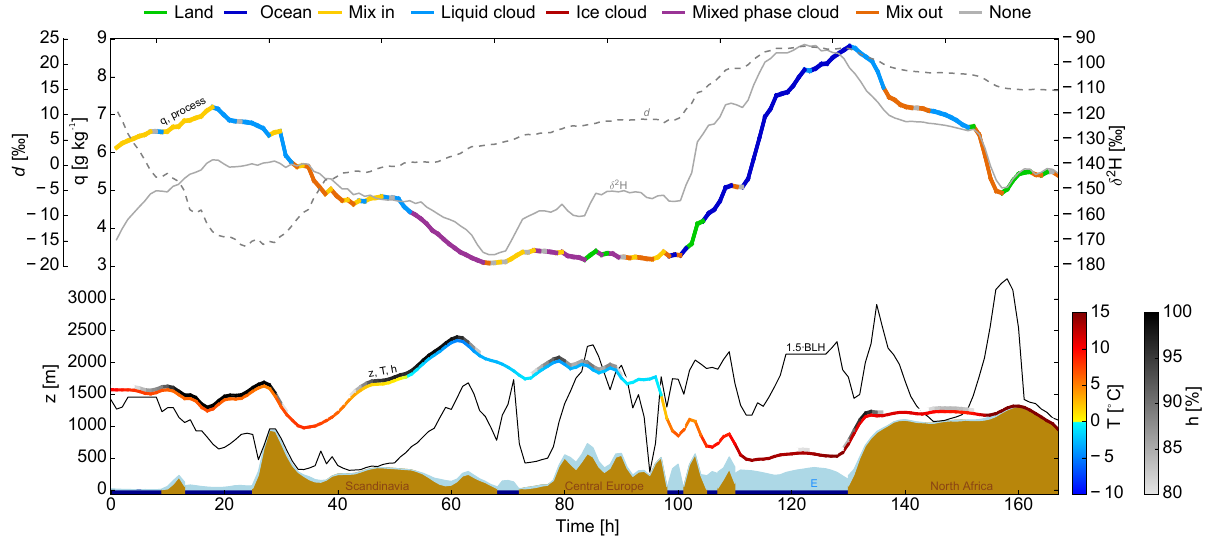
Figure 5. Time series of q (coloured with processes, see legend at the top), δ 2 H (solid grey line), d (dashed grey line), z (coloured with T and h ), 1 . 5 · BLH (solid black line), and E (light blue shading, scaled by 10 6 ) along an example trajectory arriving in north Africa (33 ◦ N, 1 ◦ E) on 3 October 1989 at 00:00UTC. The brown and blue shadings indicate land and ocean surfaces,